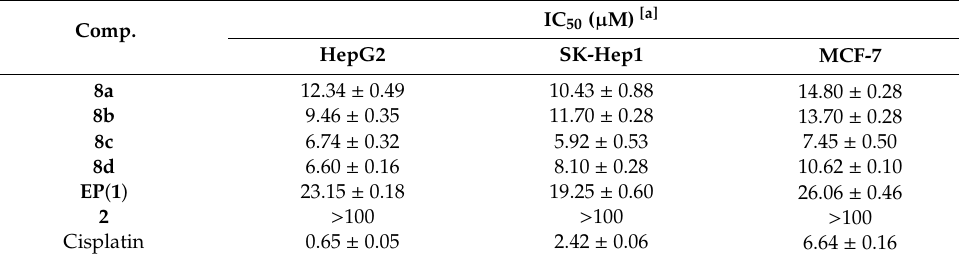
Table 2. Cytotoxicities of compounds against three cancer cell